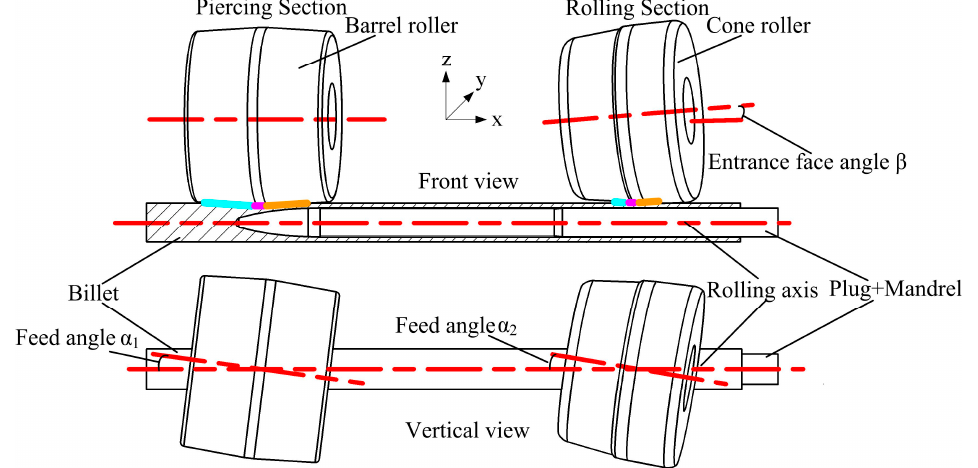
Figure 1. Diagram of the TSR process.